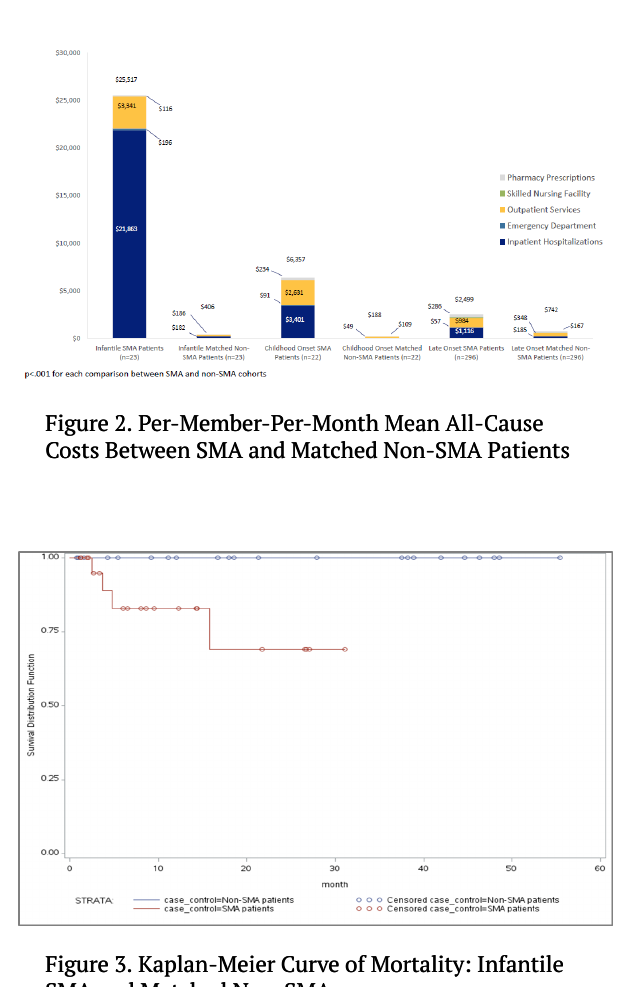
Figure 3. Kaplan-Meier Curve of Mortality: Infantile SMA and Matched Non-SMA Note: log-rank test